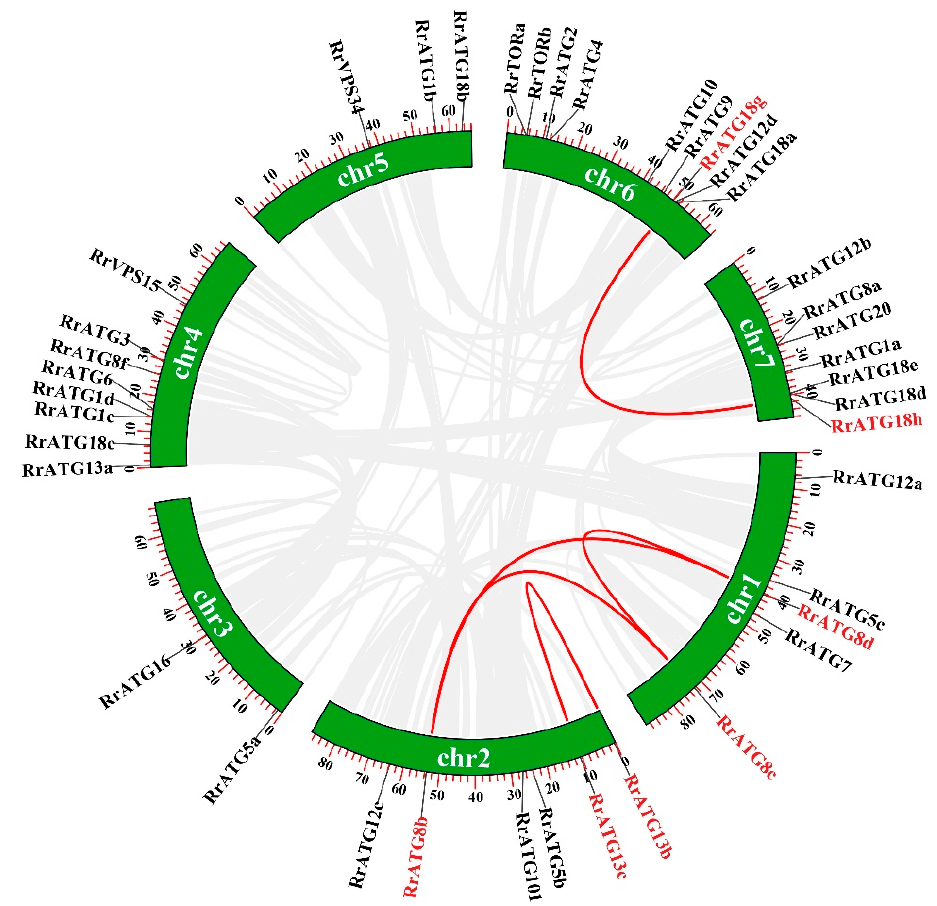
Figure 2. Chromosome distribution and gene replication of RrATG genes. Genes that had segmental duplications were highlighted in red and pairwise collinearity was linked by red